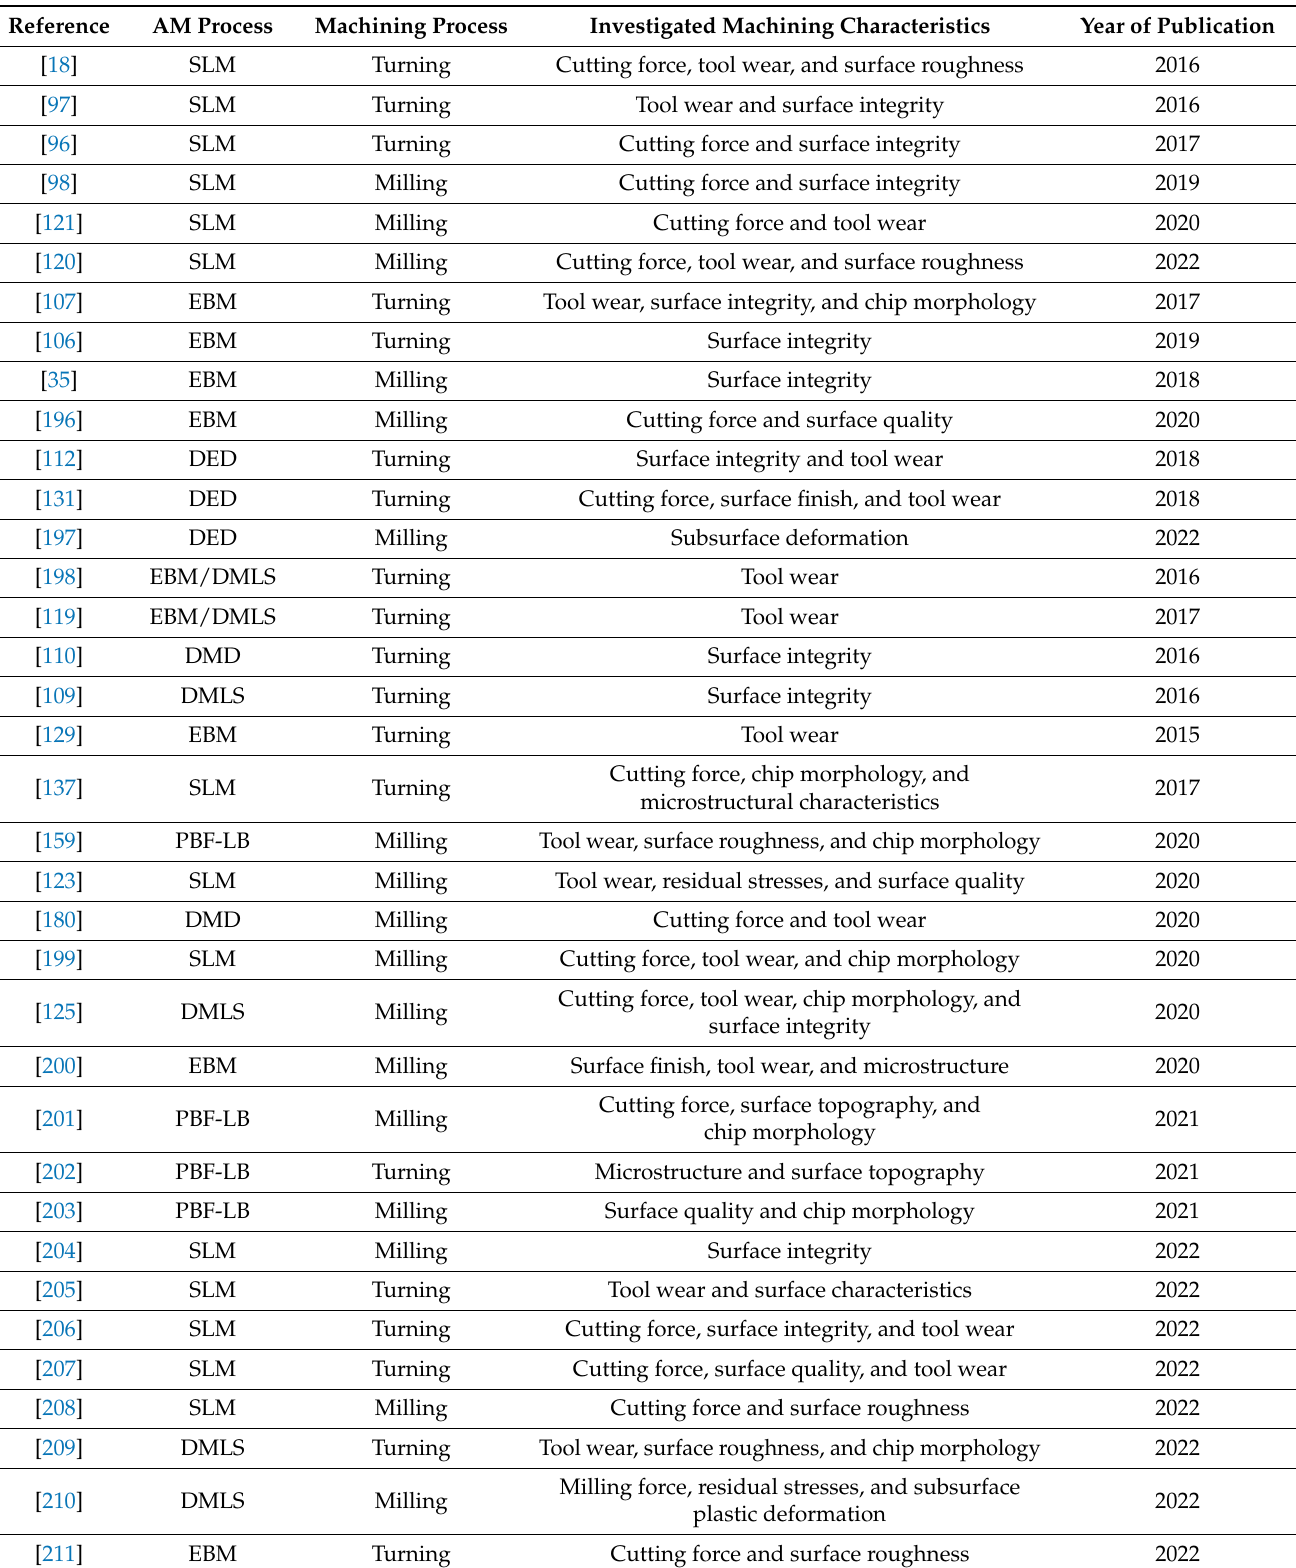
Table 1. Recent publications on machining of additively manufactured Ti-6Al-4V